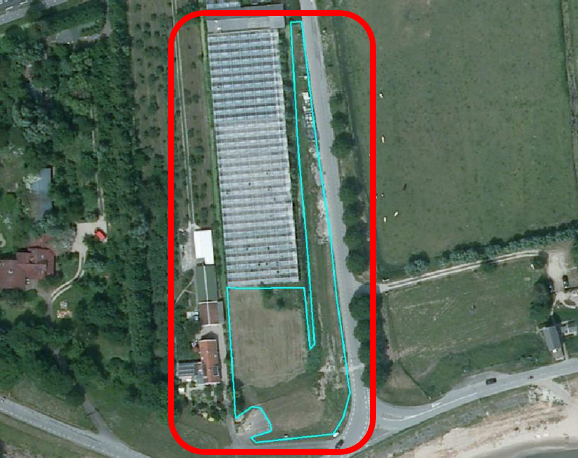
Figure 3: In this example the land use is unclear and not all parcel boundaries correspond to features in the field.